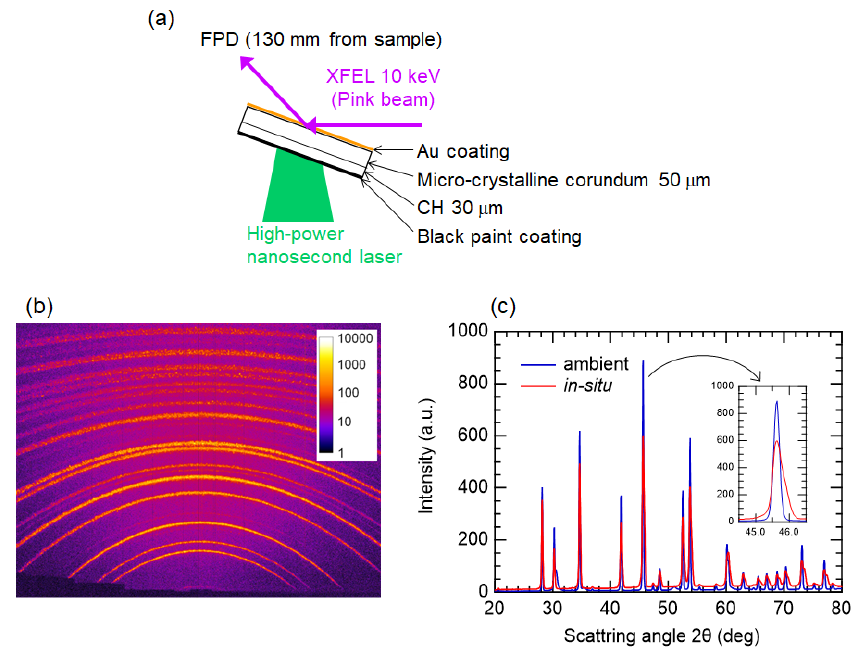
Figure 4. ( a ) Schematic of experimental setup in the reflection geometry. ( b ) In-situ single-shot diffraction pattern detected with the flat panel detector (FPD). ( c ) Line profiles of diffraction pattern of ambient and in ‐ situ. Table 1. Detectors for XRD measurements. Flat Panel Detector (FPD)